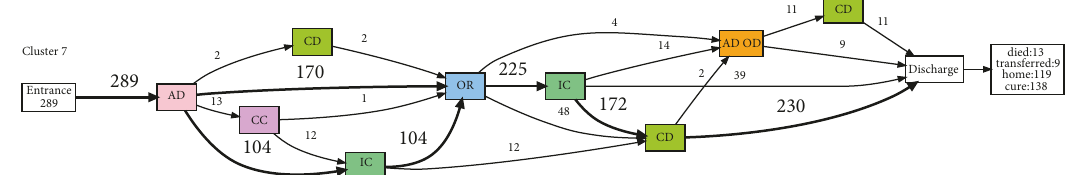
Figure 9: Example of process model showing transfers between hospital’s